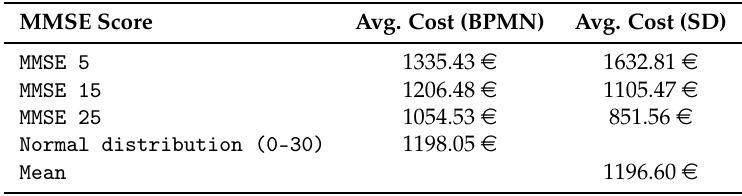
Table 8. Average cost per person/month according to the